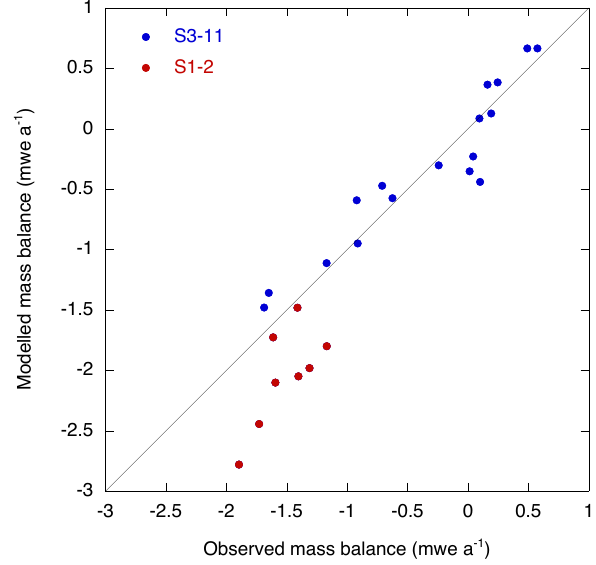
Fig. 11. Scatter plots showing observed (3-hourly) vs. modelled in- coming solar radiation (a) , reflected solar radiation (b) , incoming longwave radiation (c) and outgoing longwave radiation (d) for the period from March 2009 to November 2010.